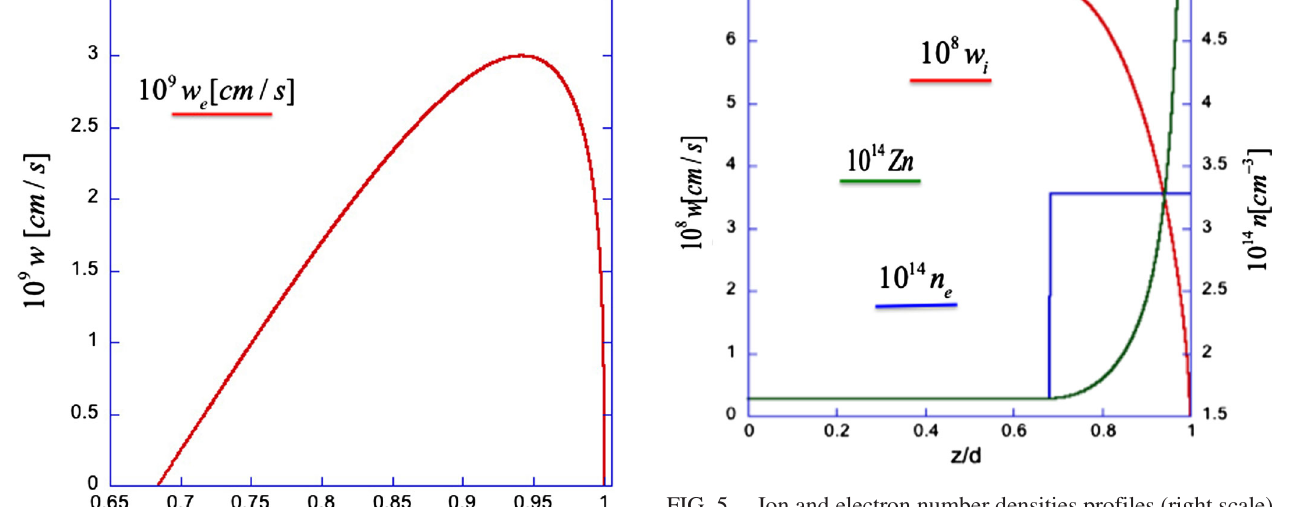
FIG. 5. Ion and electron number densities profiles (right scale), for EX in the HE regime of Sec. II B 3, and Δ I ¼ 0 . 4 MA. The ion number density in units of 10 14 cm − 3 (green), which goes to infinity at the anode (integrable singularity) is cutoff to allow comparison with the electron number density (blue), in the same units as electron number density. The ion velocity multiplied in units of 10 8 cm = s (left scale) is shown in red.